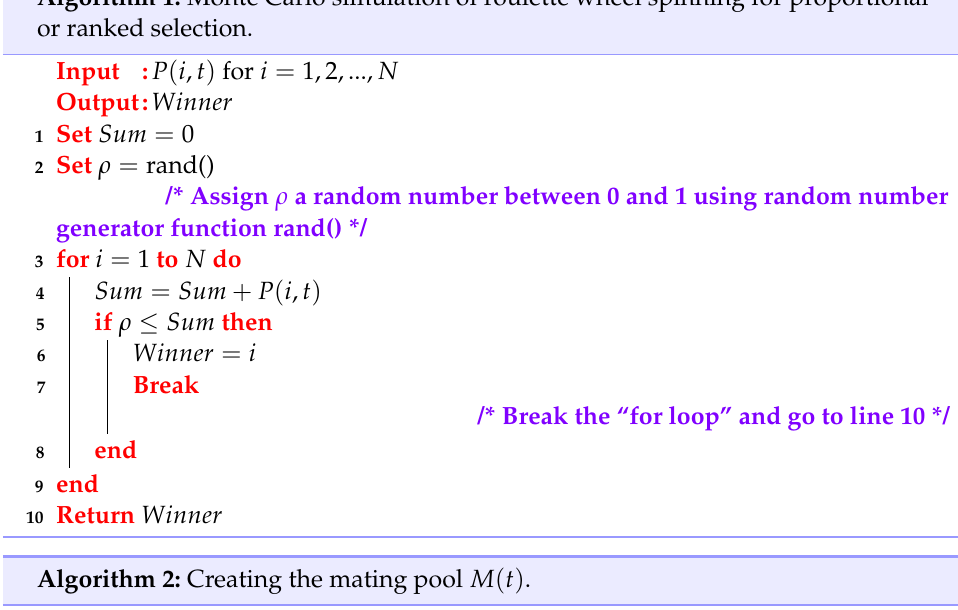
Algorithm 1: Monte Carlo simulation of roulette wheel spinning for proportional or ranked selection.